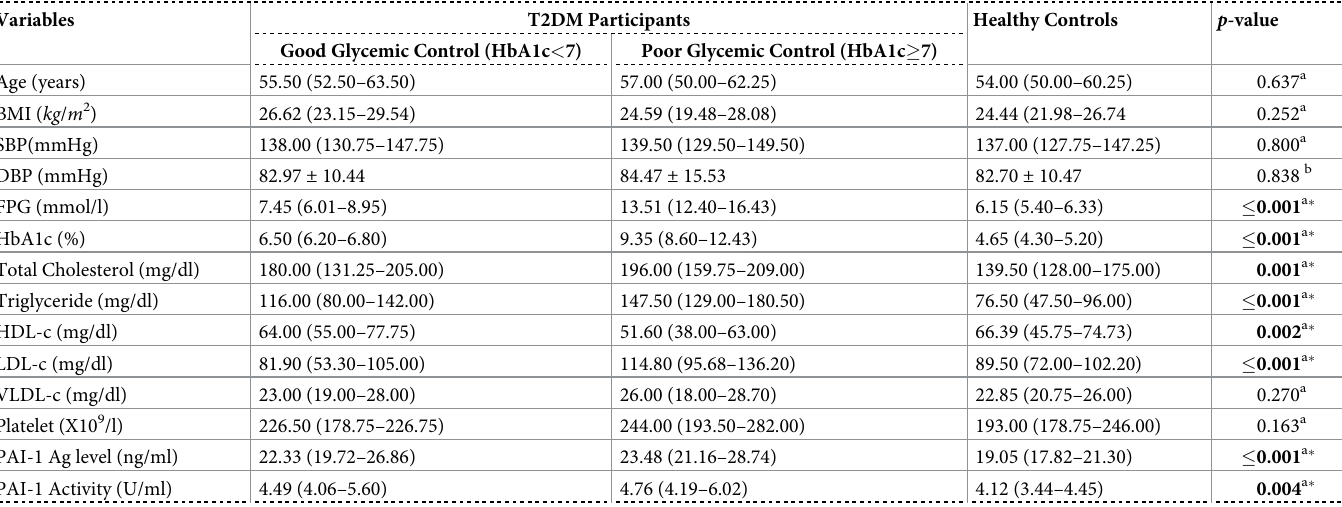
Table 2. Clinical, biochemical and hematological characteristics of the study population stratified by the states of glycemic control.